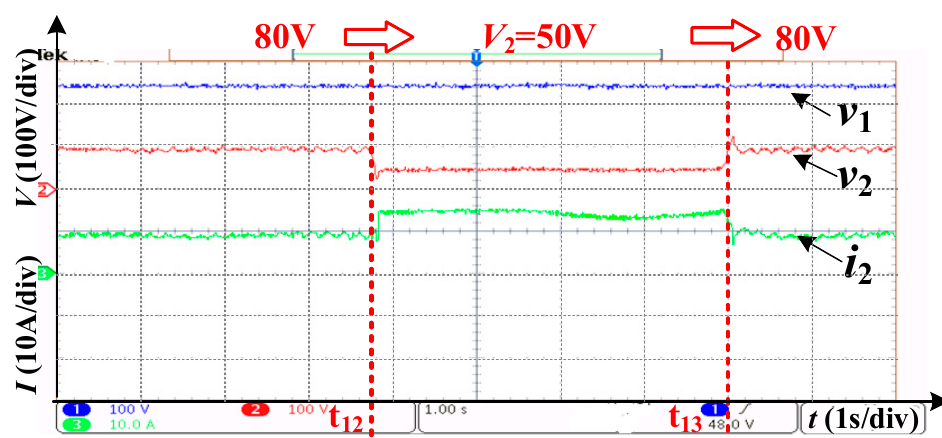
Figure 10. Waveforms in source perturbation experiment.